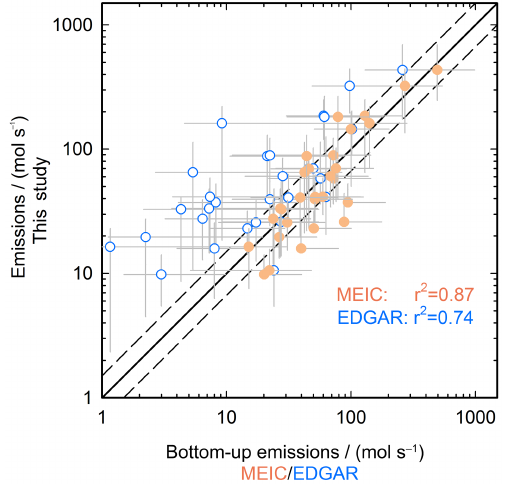
Figure 8. Same as Fig. 7 but the derived NO x emissions for inves- tigated cities versus MEIC and EDGAR estimates over